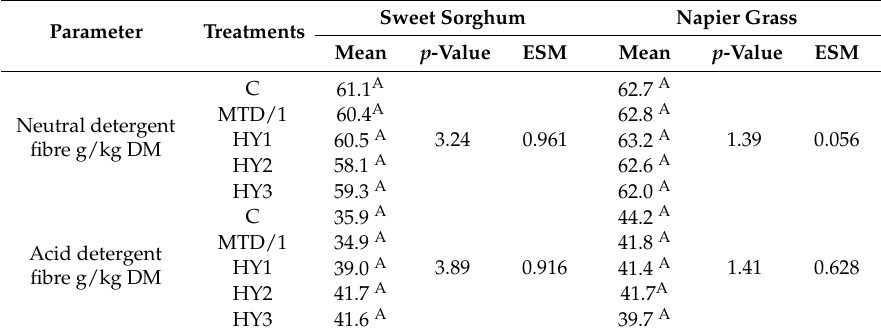
Table 5. Effects of LAB inoculant on neutral detergent fibre and acid detergent fibre contents of sweet sorghum and Napier grass at day 90 of ensiling.